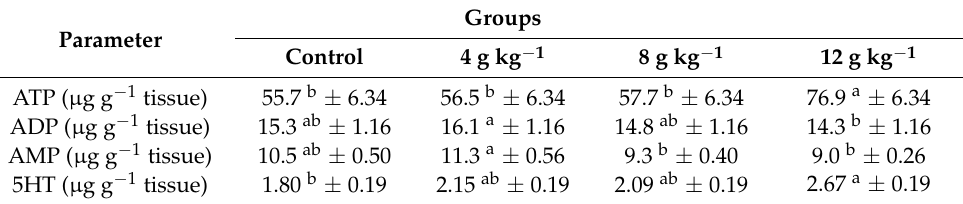
Table 8. Means ± standard errors for liver cell energy parameters and brain 5HT of growing ducks supported by S. marianum dry seeds at different levels (4, 8, and 12 g kg − 1 diet) and control during the brooding